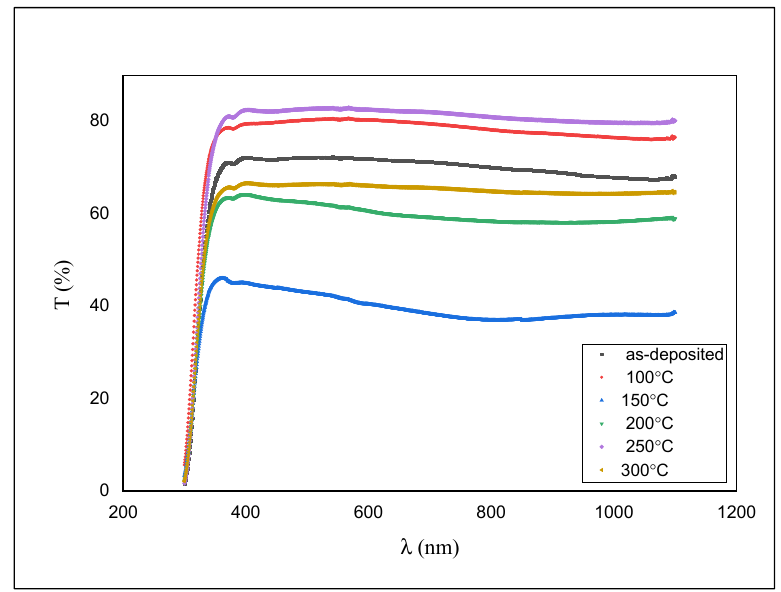
Figure 6. Transmission spectra for as-deposited and annealed ZnS films. As shown in Figure 6, the transmission is around 76% for the as-deposited film and diminished to ~50% with an expansion in the annealing temperature.